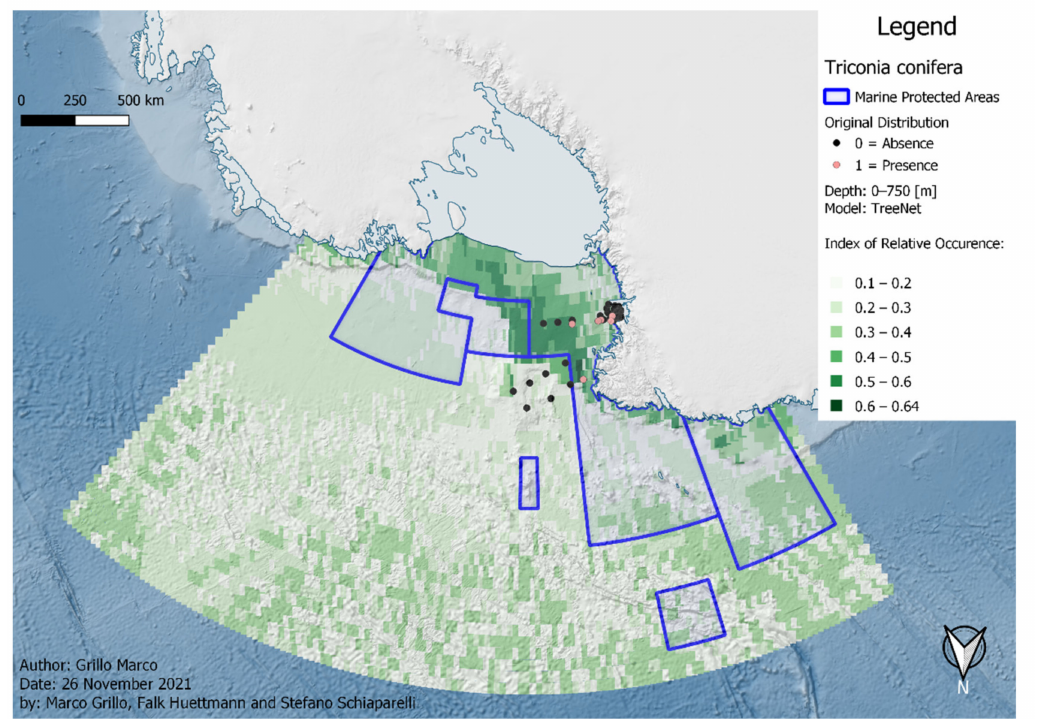
Figure 3. Presence/absence points of raw survey location shown over a predicted lattice grid distribution using the TreeNet algorithm for the depth class 0–750 m of the copepod Triconia conifera . For details, see legend.